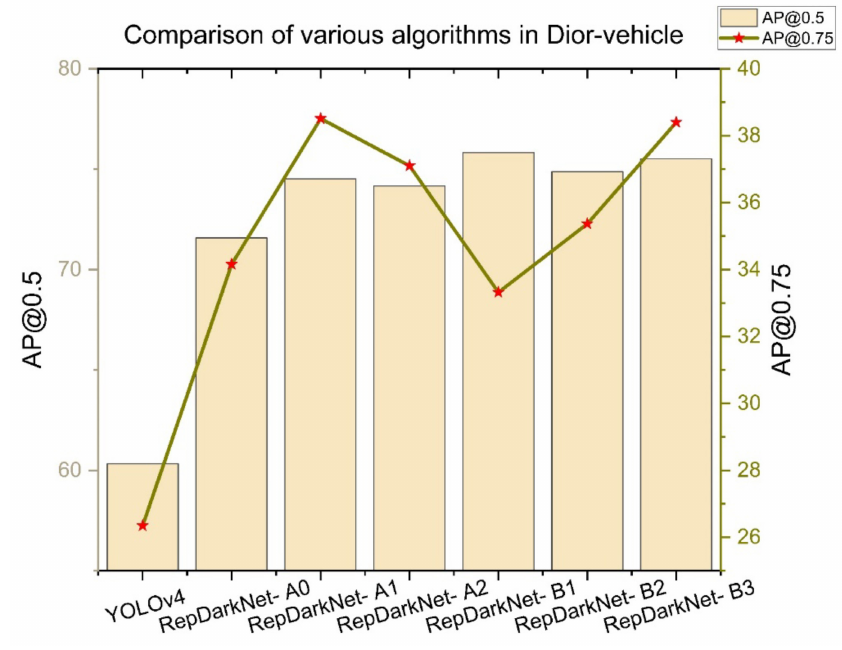
Figure 6. Comparison of various algorithms in